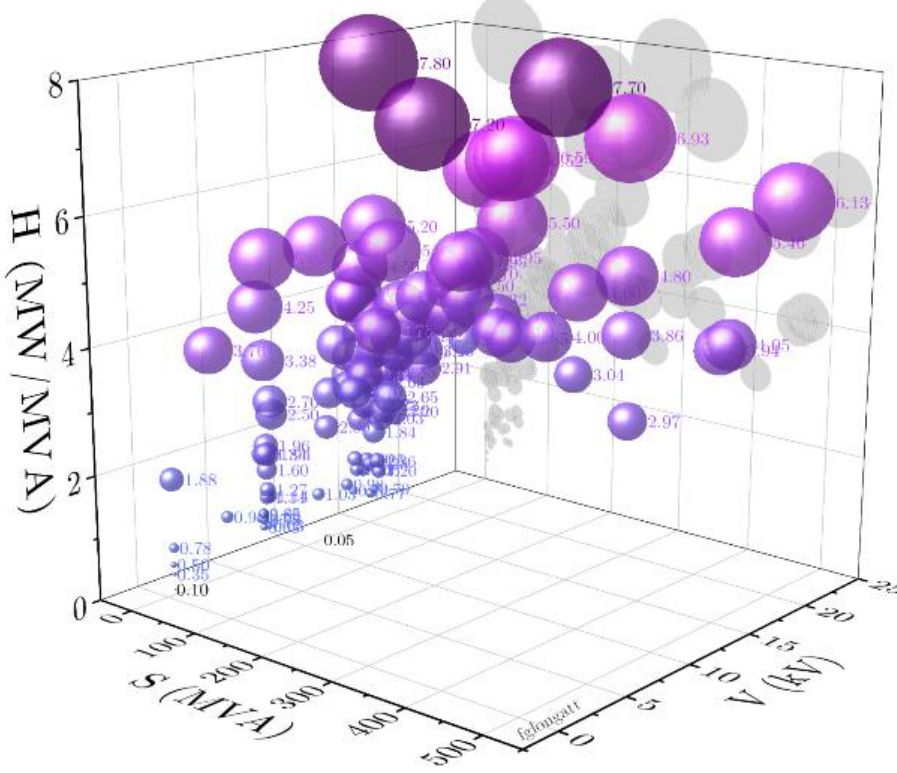
Figure 6. Representation of the rotational inertia versus rated apparent power and rated voltage: Chilean power system.